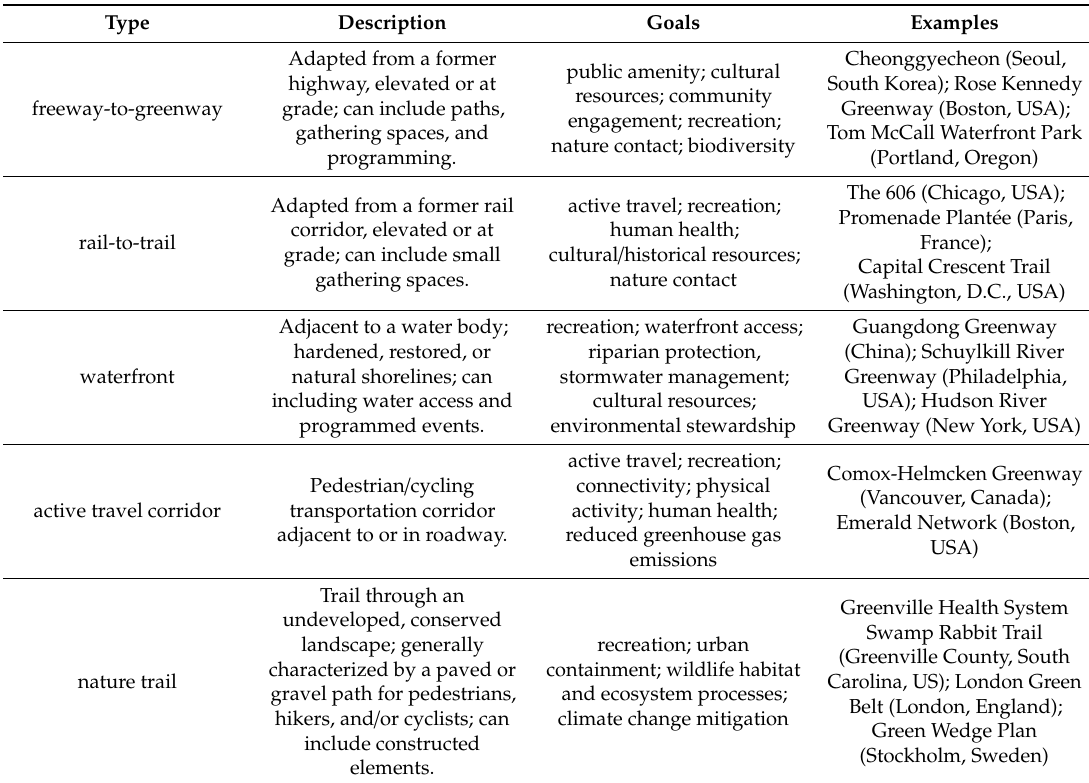
Table 6. Urban greenway